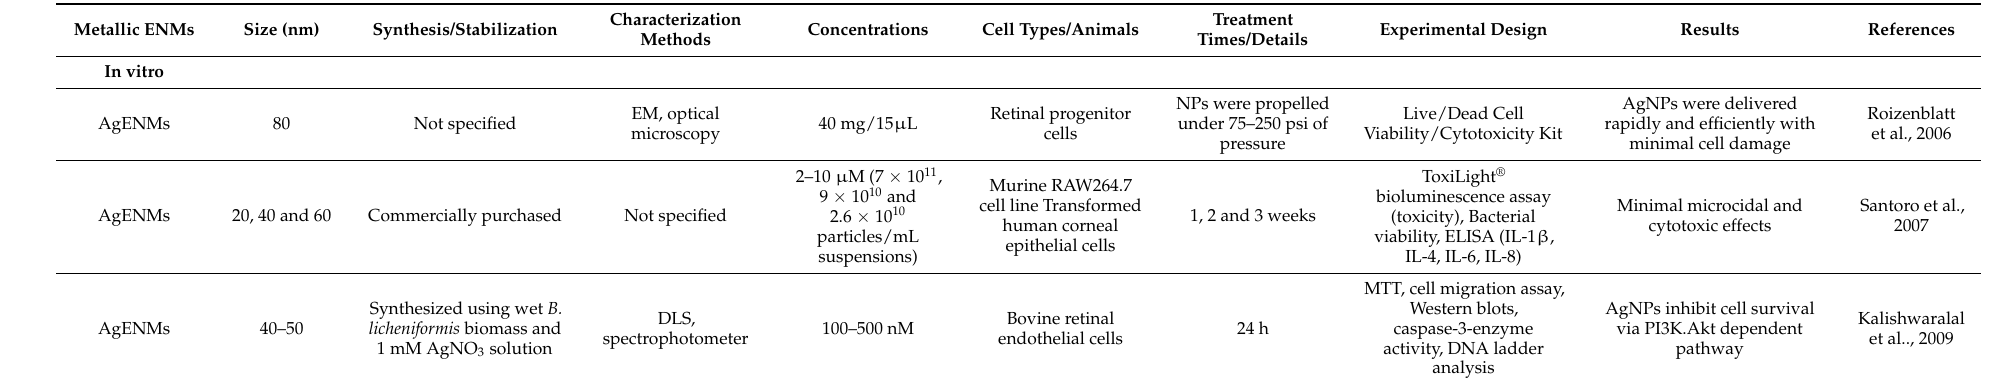
Table 2. Published studies using silver nanoparticles (AgENMs) in